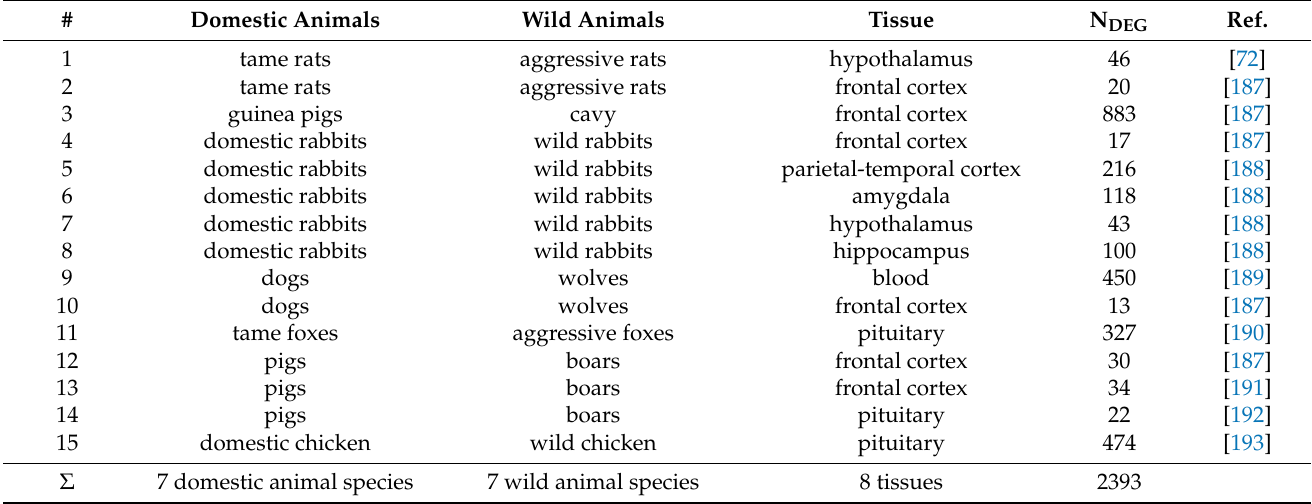
Table 8. The investigated genome-wide RNA-Seq transcriptomes (of domestic animals with their wild congeners) that we could find in the PubMed database [69].